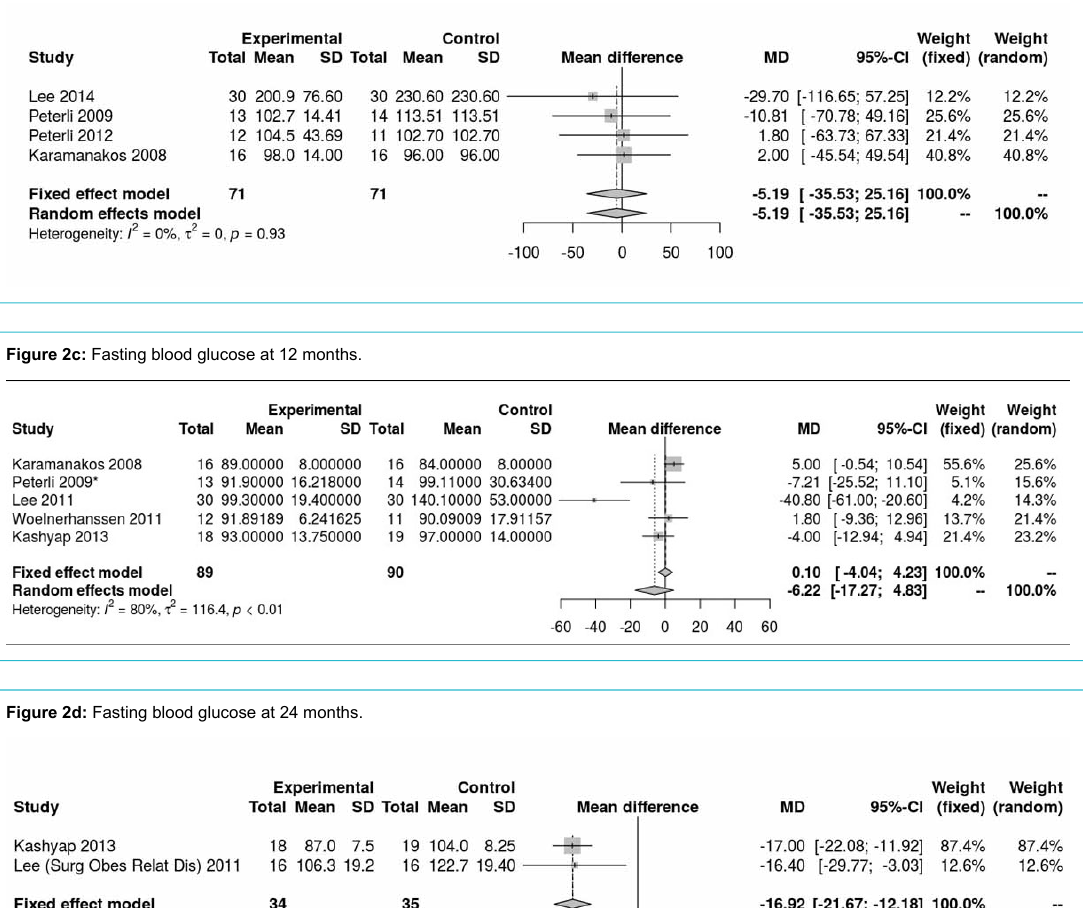
Figure 2b: Fasting blood glucose at baseline without Schauer et al. 2014 [13].